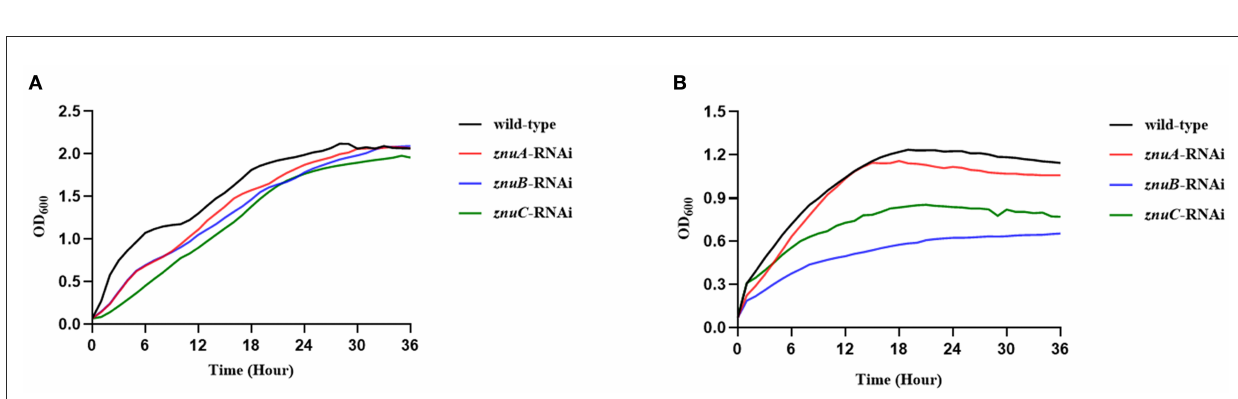
FIGURE2 Determination of growth ability in metal ion limited environment. (A) was the growth curve under the condition of Zn 2 + restriction environment. (B) was the growth curve under the condition of Fe 2 + restriction environment.